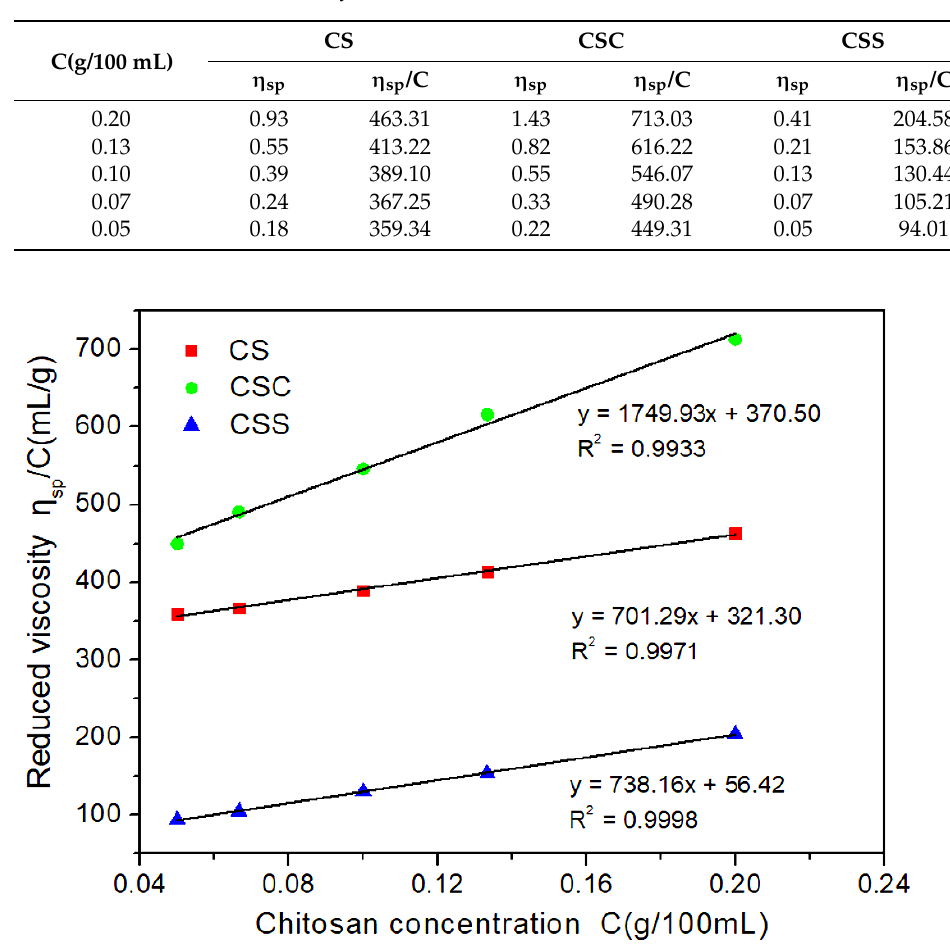
Figure 2. η sp /C-C diagram of chitosan. Table 3. Raw data of chitosan chemistry performance indexes.